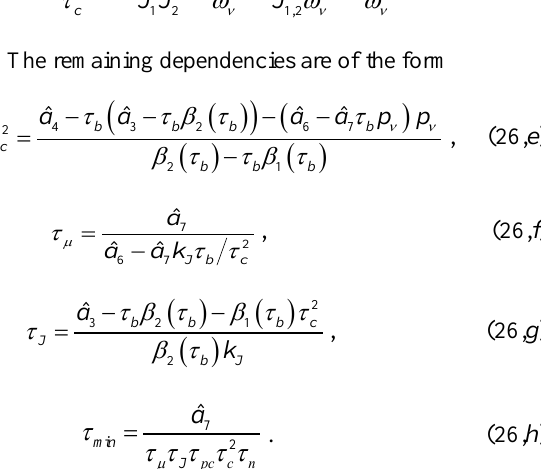
Table 4. Examples of reference polynomials.